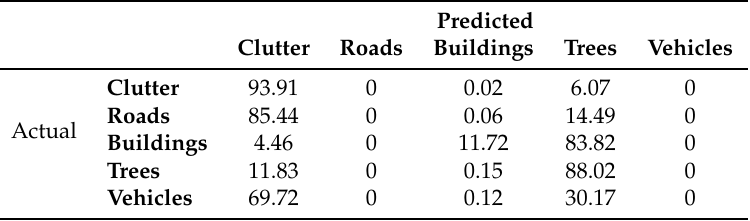
Table A11. Normalized confusion matrix for the decision tree model that is trained on hand-crafted coordinates features.